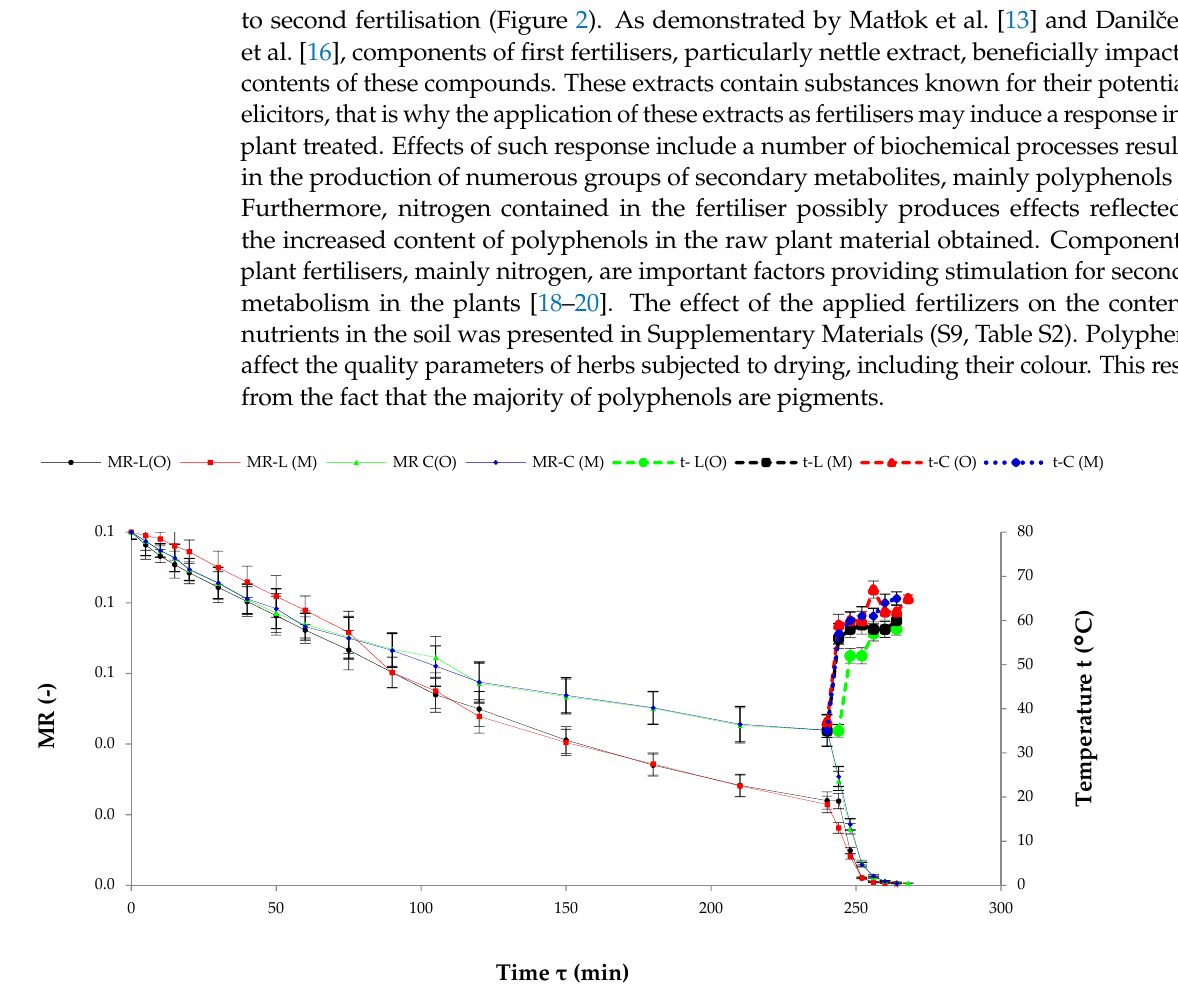
Figure 1. Water content decrease in Coriandrum sativum L. and Levisticum officinale plants during vacuum microwave drying after convection drying (CPD) at 40 °C, followed by final vacuum microwave drying (VMFD). Note: MR = moisture ratio, L = lovage, C = coriander, (O) = first fertilisation, (M) = second fertilisation, t = temperature.